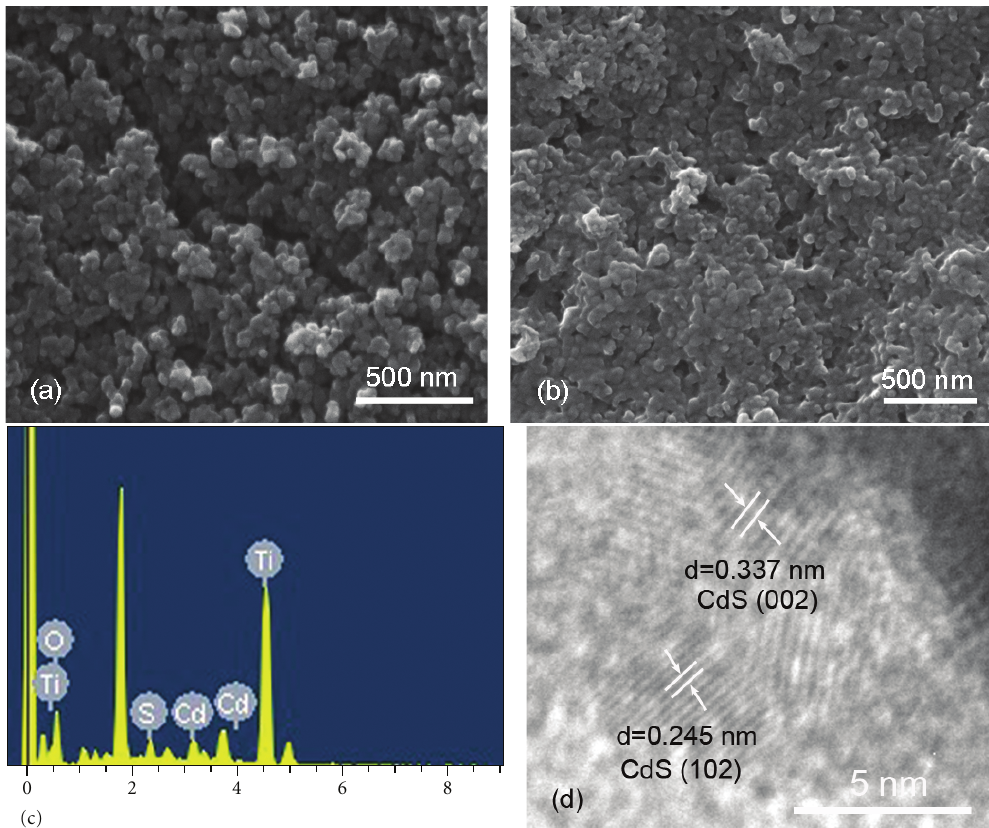
Figure 2: SEM images of TiO 2 nanocrystalline film (a) before and (b) after CdS quantum dots deposition. (c) EDS spectra of CdS-modified TiO 2 . (d) TEM image of CdS quantum dots.